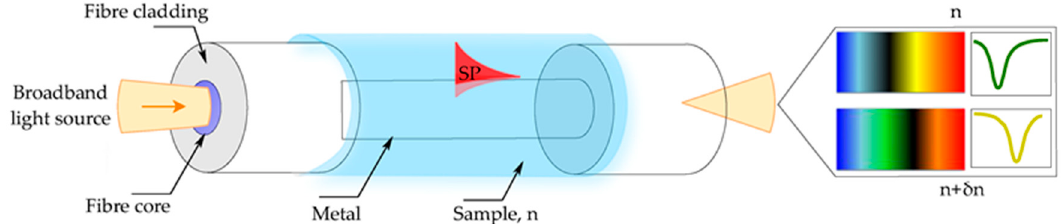
Figure 1. Optical fiber sensor based on surface plasmon resonance (SPR). Illustration of the working principle of the fiber-based SPR sensor. The shift of the plasmon resonant wavelength is associated with the change in the refractive index of the sample ( δ n) defining the resonant condition. Reproduced with permission from [21].